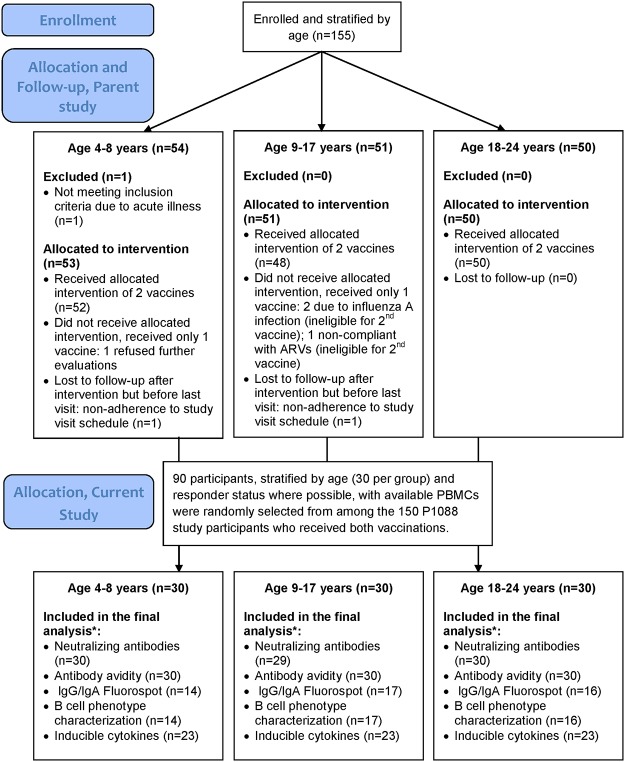
Flow Chart after Enrollment.Abbreviations: ARVs, antiretrovirals; HAI, hemagglutinin inhibition; PBMCs, Peripheral blood mononuclear cells. *Reasons for exclusion from the final analysis included: insufficient sample to perform assay, invalid results of assay